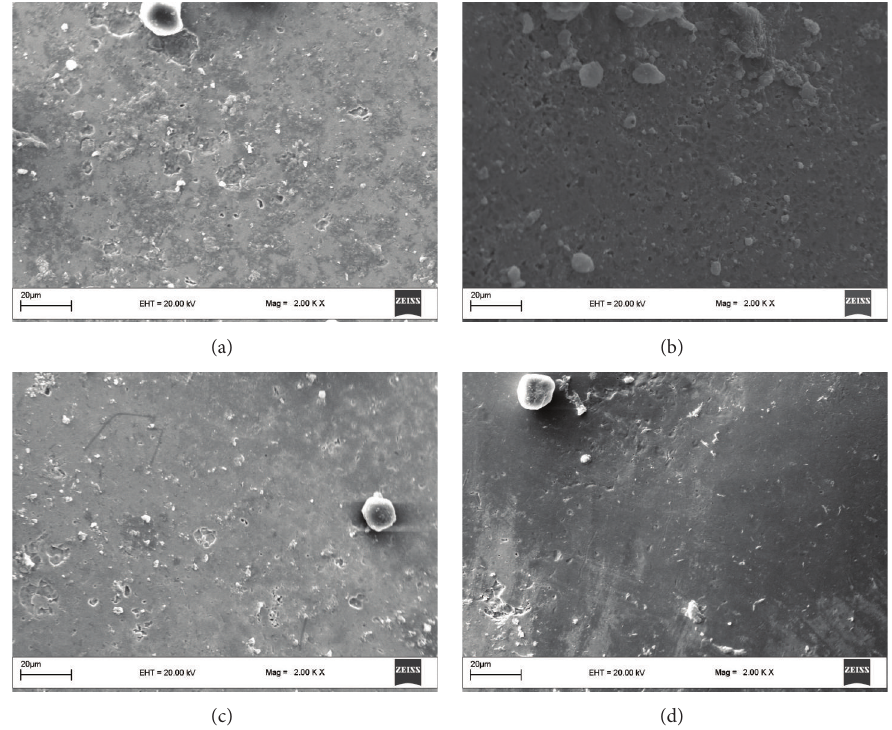
Figure 3: SEM images (2000x magnification) of the specimens from (a) Er:YAG laser, (b) control, (c) ACP, and (d)